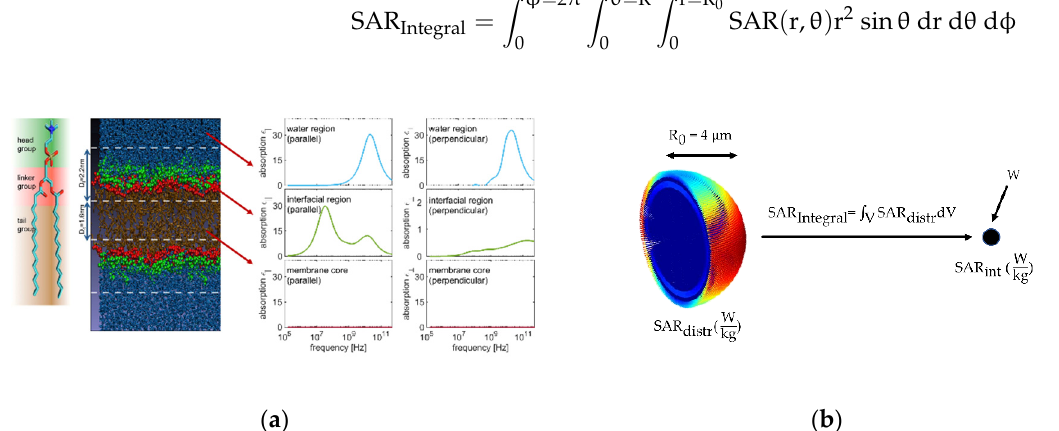
Figure 4. ( a ) The phospholipid DPPC forms a bilayer in a simulation box with water. Spatial dependent absorption spectra are calculated from the equilibrium simulations [25]; ( b ) 3D-SAR distribution for an exemplary small cell is integrated and reduced to a single point absorber.